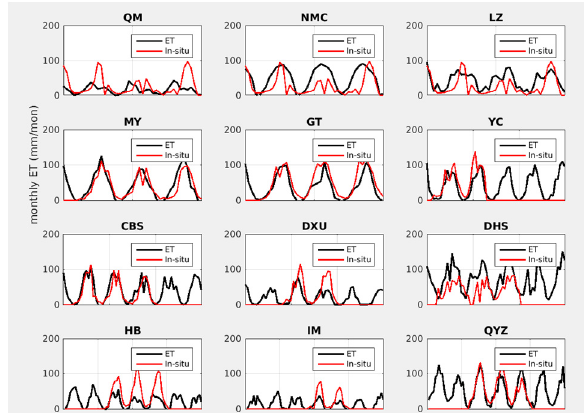
Fig. 3 Time series of monthly ET simulation and in-situ